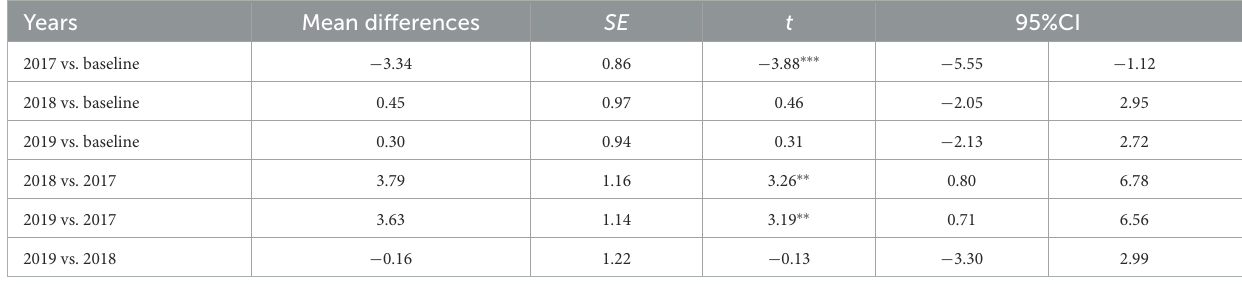
TABLE 5 Multiple comparisons: mean differences and confidence intervals for standing-long-jump across mean baseline (2013–2016), 2017, 2018, and 2019. Years Mean differences SE